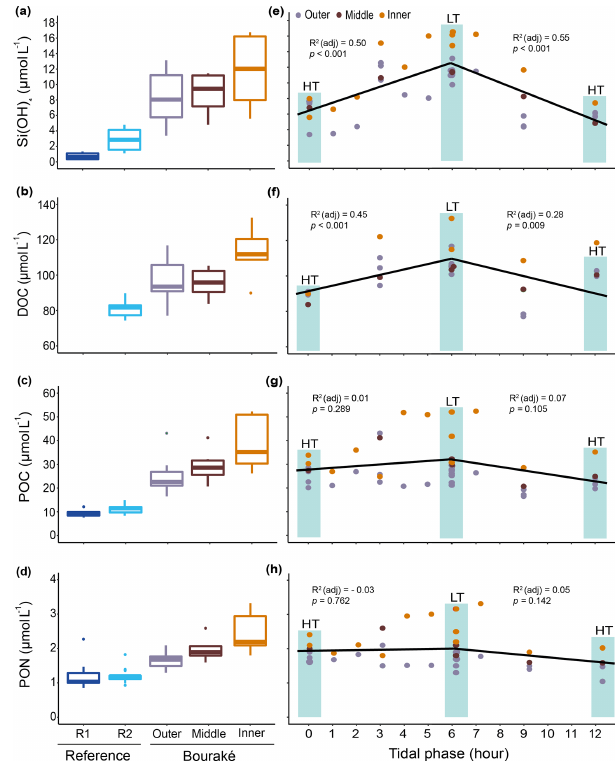
Figure 9. Orthosilicic acid, organic carbon, and nitrogen parameters measured during diel cycles in 2017 and 2019 (pooled data; see also Fig. S2) at R1, R2, and the Bouraké reefs (outer, middle, and inner) (a–d) . Boxes ( n = 6–14) represent the interquartile range (25th and 75th percentiles); the horizontal line is the median, and the whiskers represent the data range (i.e., minimum and maximum). Changes are illustrated across a 12h tidal phase in Bouraké (e–h) . Linear regression lines are plotted for each falling (HT to LT) and rising (LT to HT) tide. Shaded boxes have only a graphical significance and only suggest the tide changes during